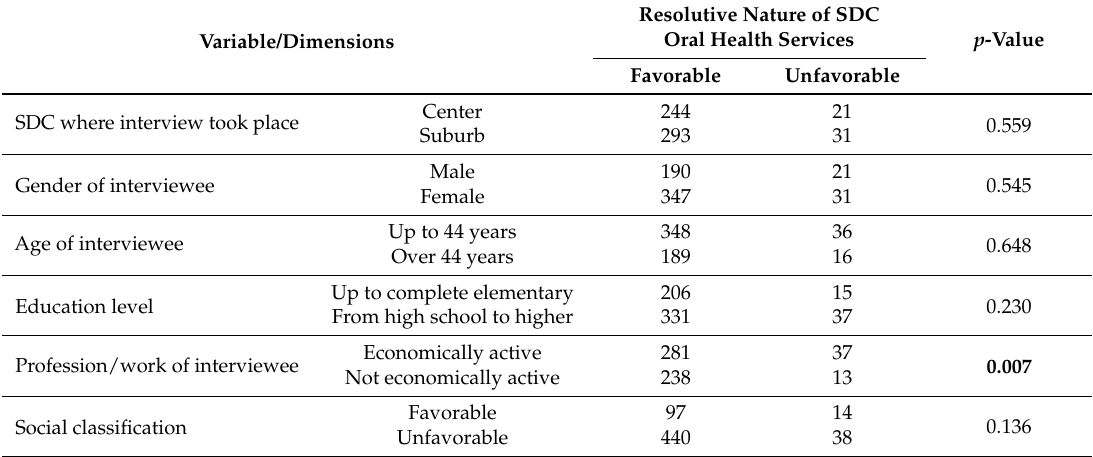
Table 4. Bivariate analysis (Fisher’s exact test) of users’ perceptions in relation to the resolutive nature of the Specialized Dental Clinics (SDC)’s oral health services and sociodemographic variables ( n =